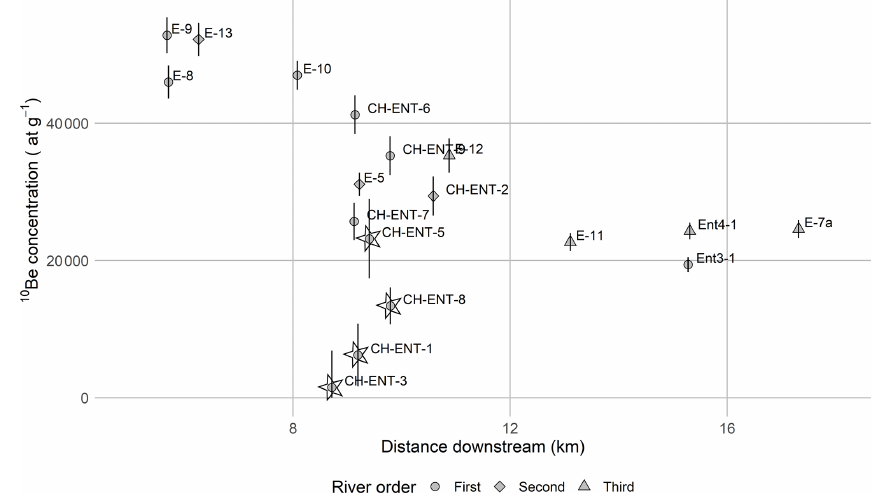
Figure 5. 10 Be concentrations (atoms g − 1 ) along the river network of the Entle catchment. Downstream distance is computed from the river source to the outlet of the Entle catchment. Samples from the earthflow-affected Schimbrig catchment are marked with a